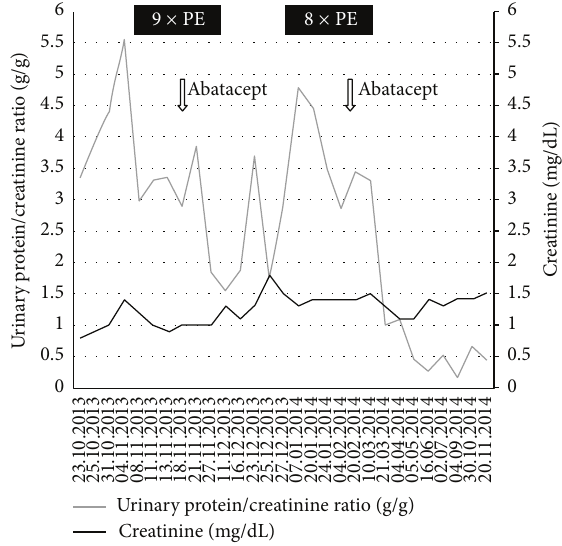
Figure 3: Time course of serum creatinine and proteinuria in relation to therapeutic